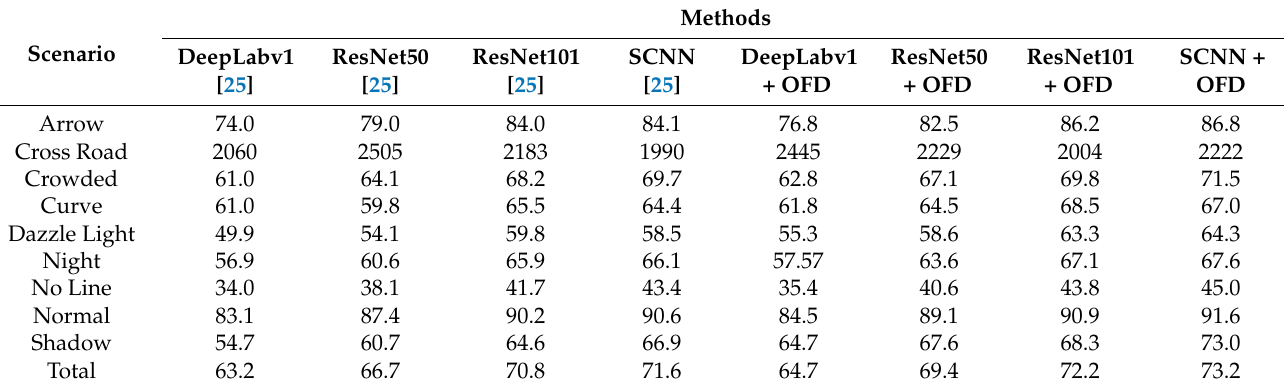
Table 3. Experimental results of the application of target feature distillation method to the main stream lane segmenta- tion method.